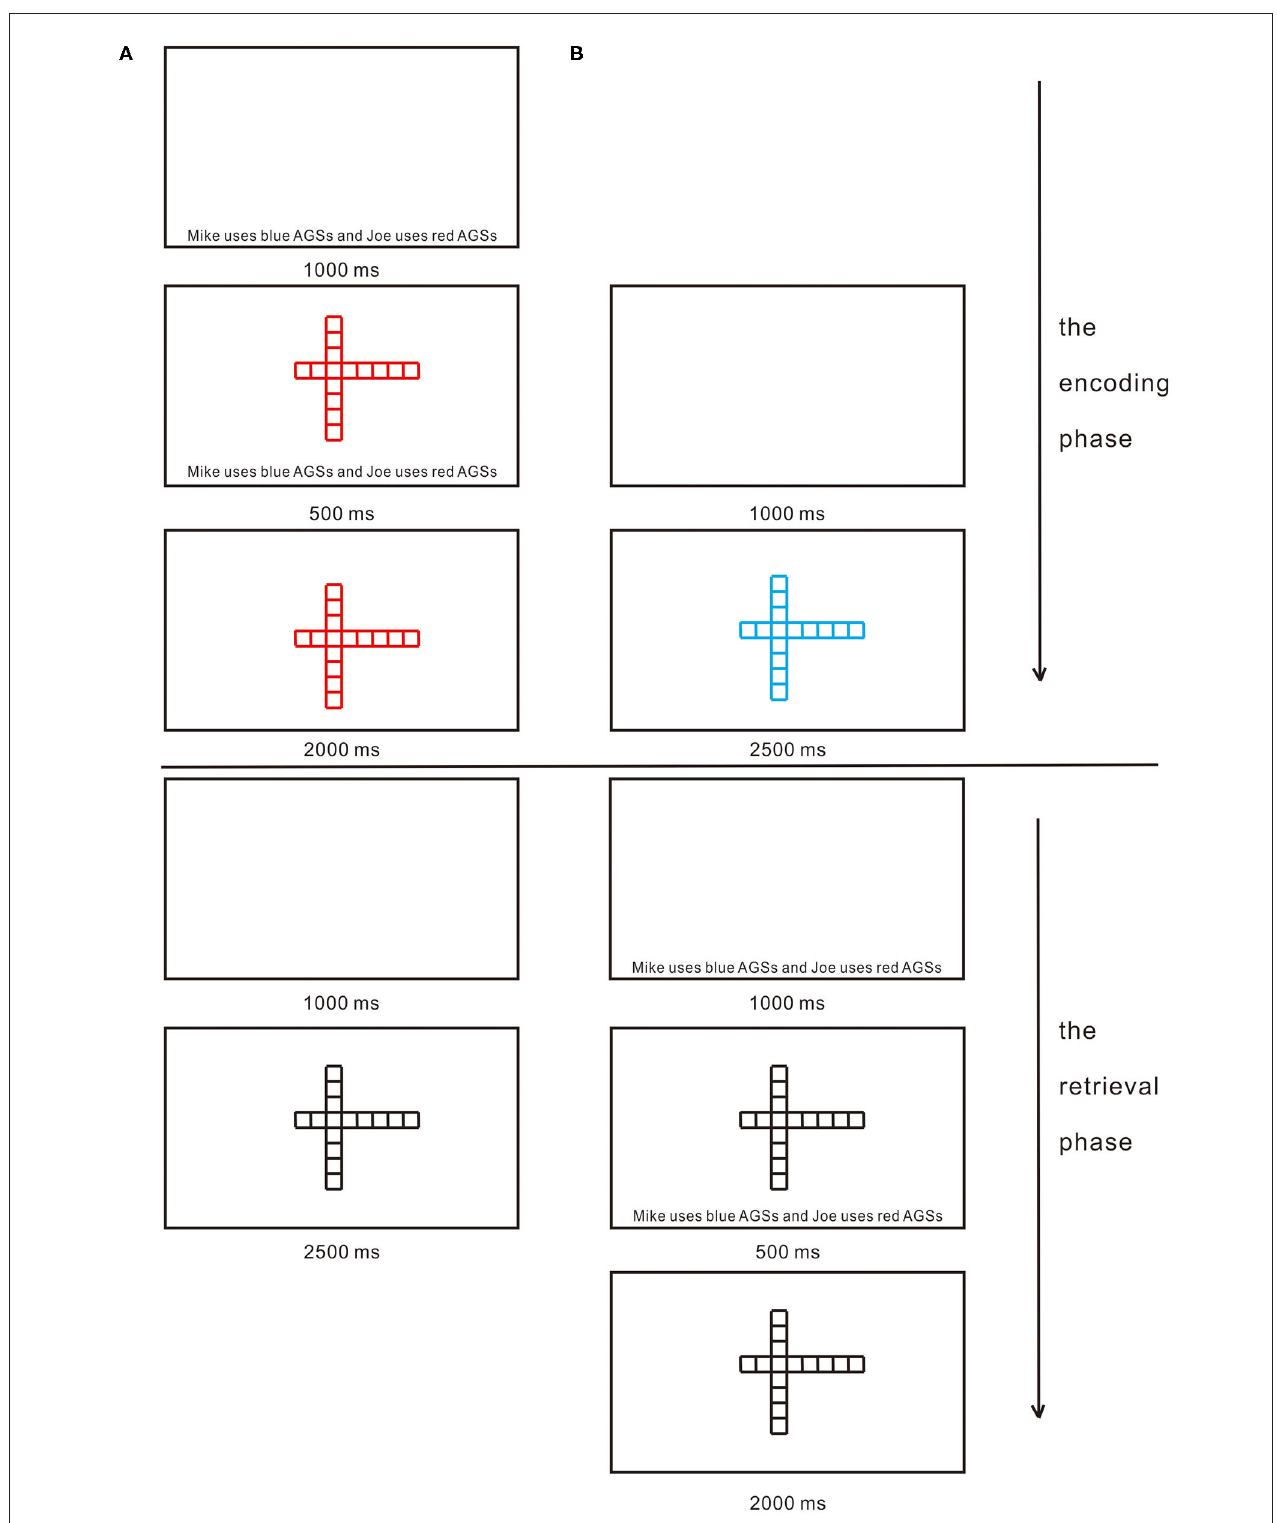
FIGURE 2 | Timeline of stimuli. (A) The encoding and retrieval phases under the cue-in-encoding (CIE) condition. (B) The encoding and retrieval phases under the cue-in-retrieval (CIR) condition. For each participant, abstract geometric shapes (AGSs) were randomly divided into three equal lists. In the encoding phase in CIE